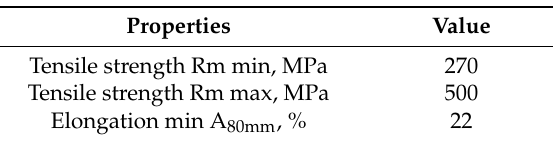
Table 1. Mechanical properties of adherends [48].